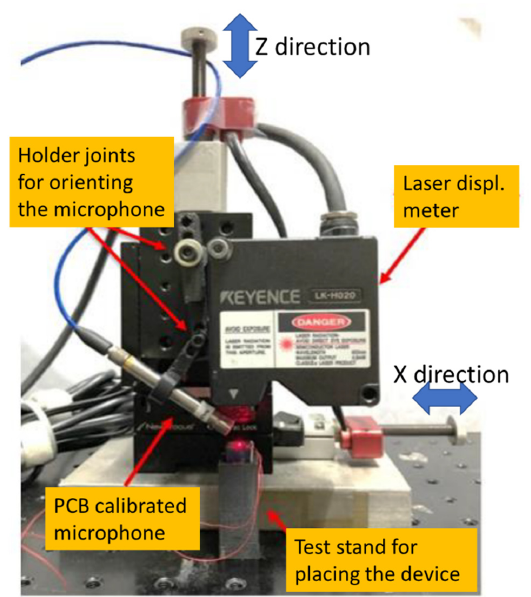
Figure 6. Experimental setup for acquiring the displacement and ultrasonic signals of the fabricated